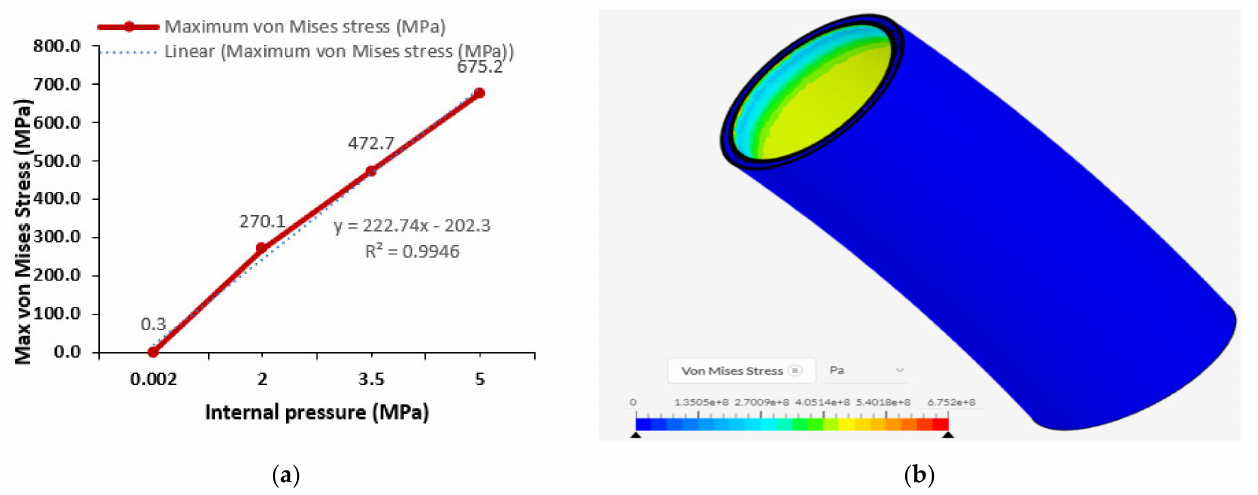
Figure 18. Stress Profile of the bonded flexible hose under internal pressure, showing ( a ) the von Mises stress profile under internal pressure at 5 MPa, and ( b ) Maximum von Mises stress of the